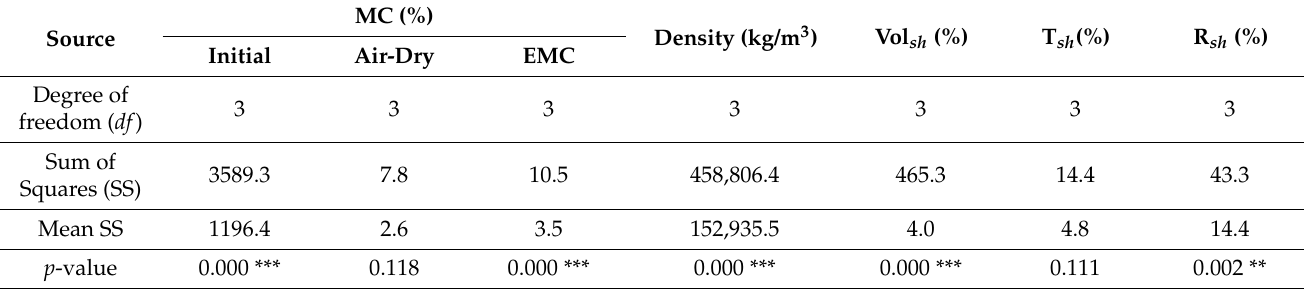
Table 3. Summary of analysis of variance (ANOVA) for the effect of infection by Crysoporthe deuterocubensis on the physical properties of Eucalyptus urograndis lumbers.